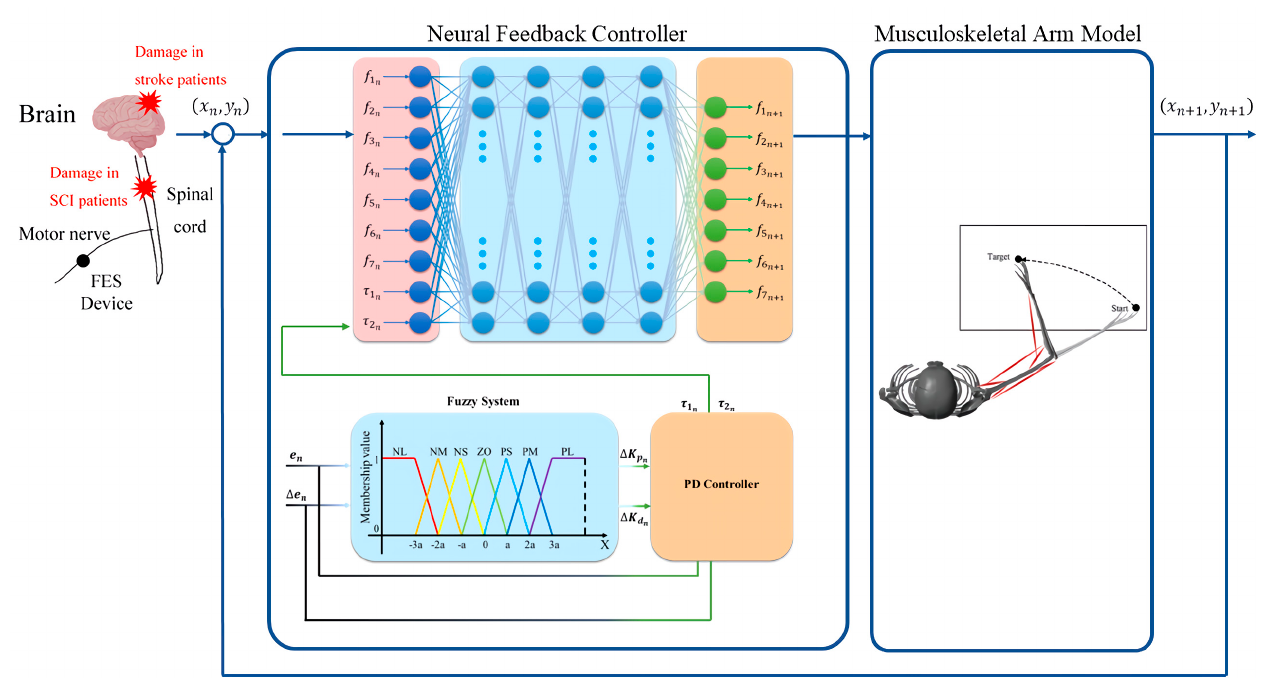
Figure 6. Block diagram of the neuromechanics − based neural feedback controller for arm reaching movements.